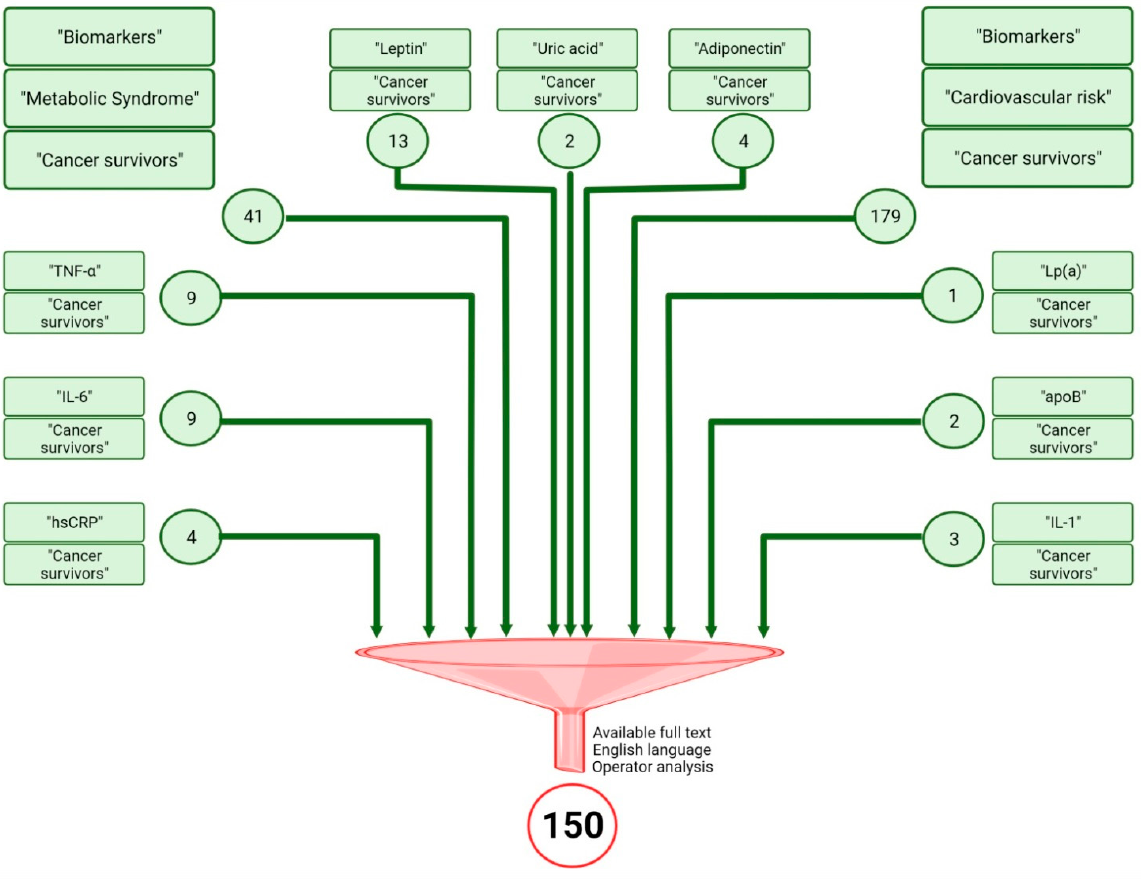
Figure 1. Research methods. The figure shows the results of the research carried out on PubMed. The rectangles contain the search terms. The number of articles obtained from the individual searches are contained in the circles. All articles obtained were analyzed according to the filters noted adjacent to the funnel. The final number of articles included in the review is 149.